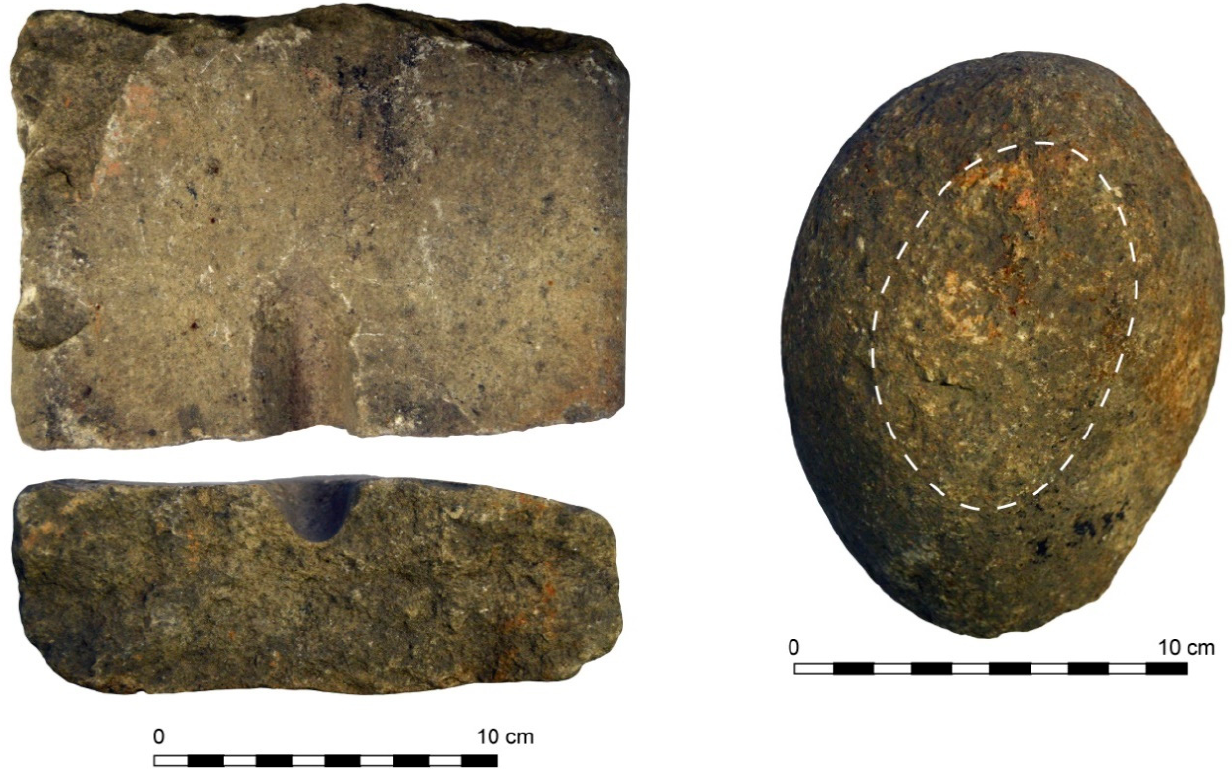
Figure 7. Lithic artefacts related to metallurgy and ore processing from Outeiro de Baltar hillfort: a broken mold ( left ) and a hammerstone to crush ore ( right ).